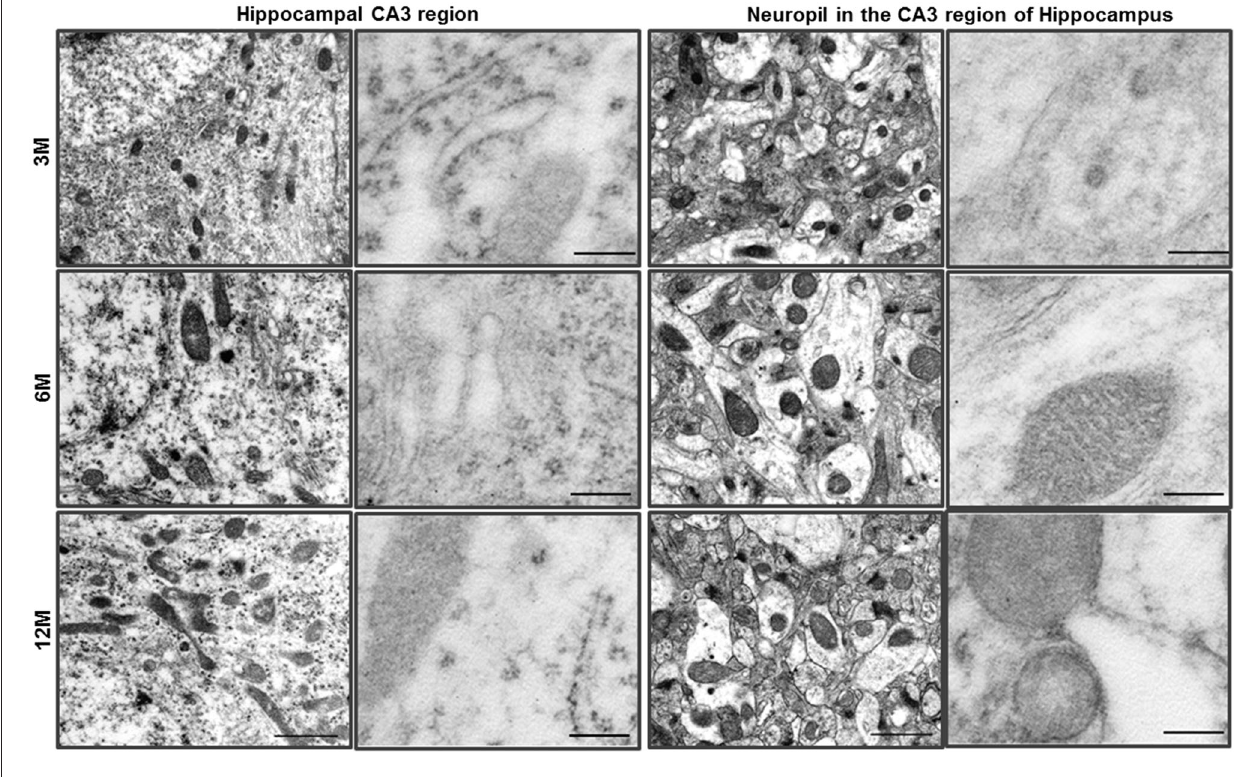
FIGURE 1 | Ultrastructural analysis of the hippocampus in C57BL/6J mice . The neurons of the hippocampal CA3 region of C57BL/6J mice exhibited a pale nucleus and normal organelles. LC3B immunogold particles were not